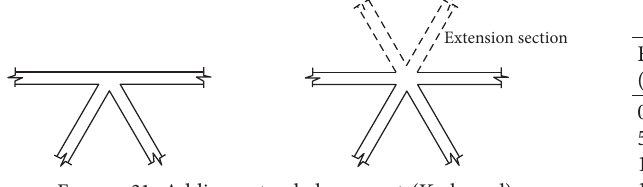
Figure 31: Adding extended segment (K-shaped).